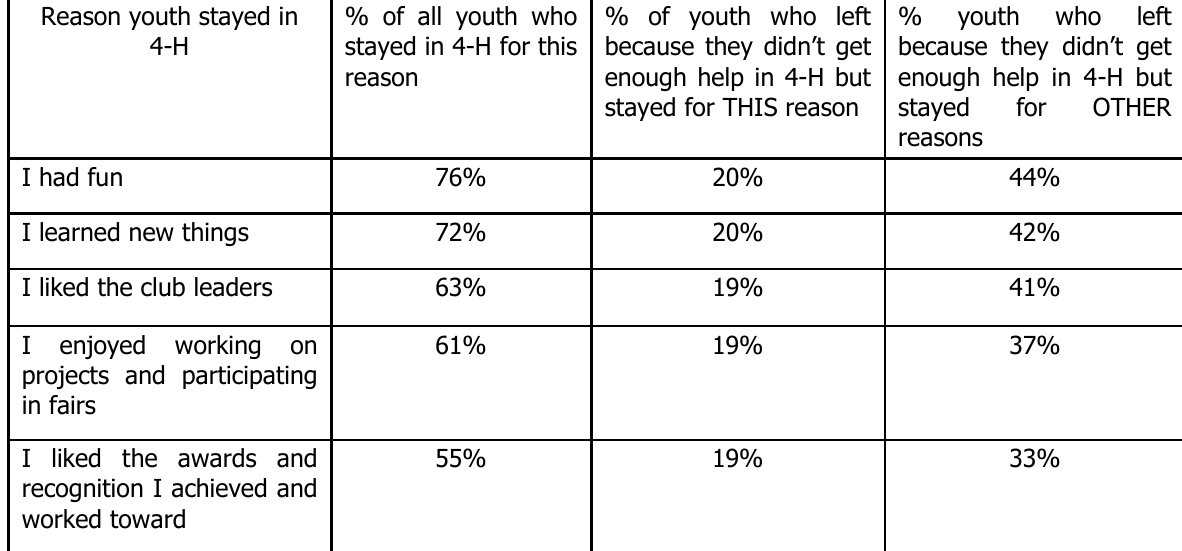
Differences in Reasons for Staying Among Youth Who Left